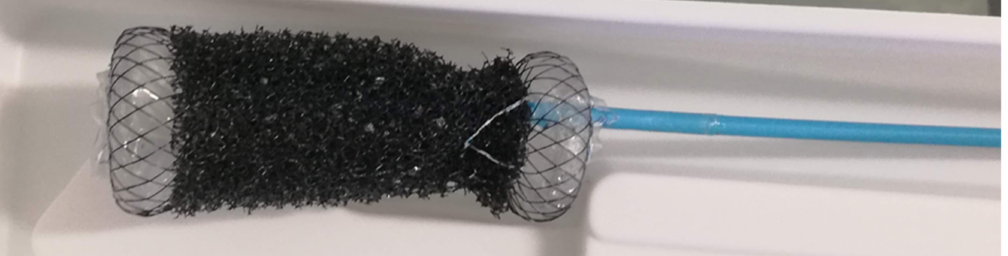
Figure 3. New combination device VACStent (Möller Medical GmbH, Fulda, Germany); the blue drain is connected to an electric vacuum pump. The device could be in place for 5